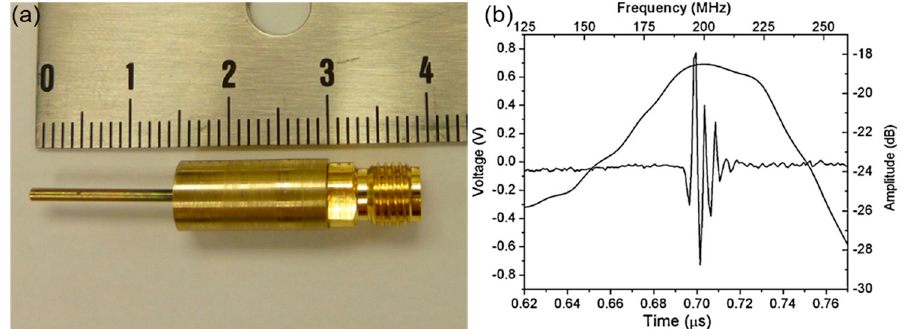
Figure 29. ( a ) Photograph of the completed needle transducer. ( b ) Pulse echo response of the single-element KNN–LSO transducer [75]. © Copyright 2010, Sens. Actuators A